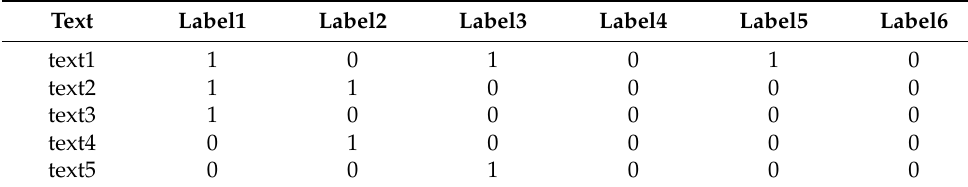
Table 2. The data format before problem transformation.